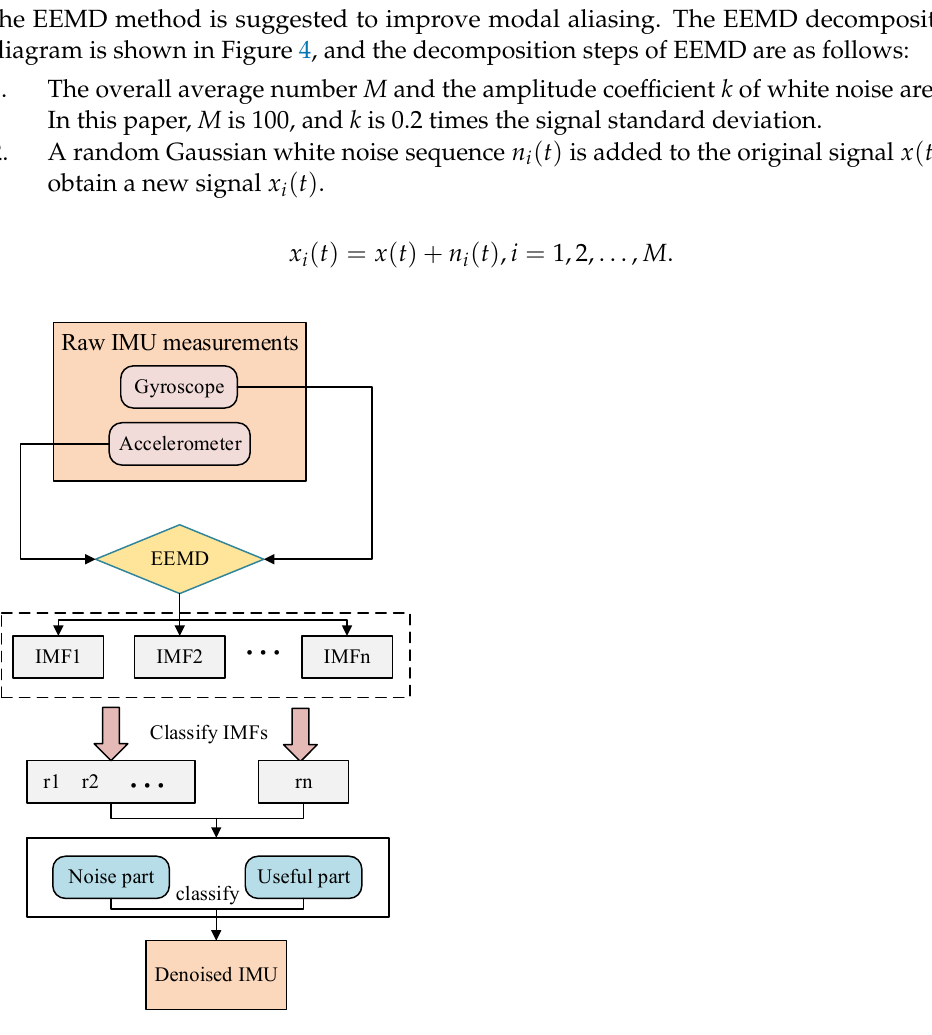
Figure 4. Ensemble empirical mode decomposition (EEMD) process.